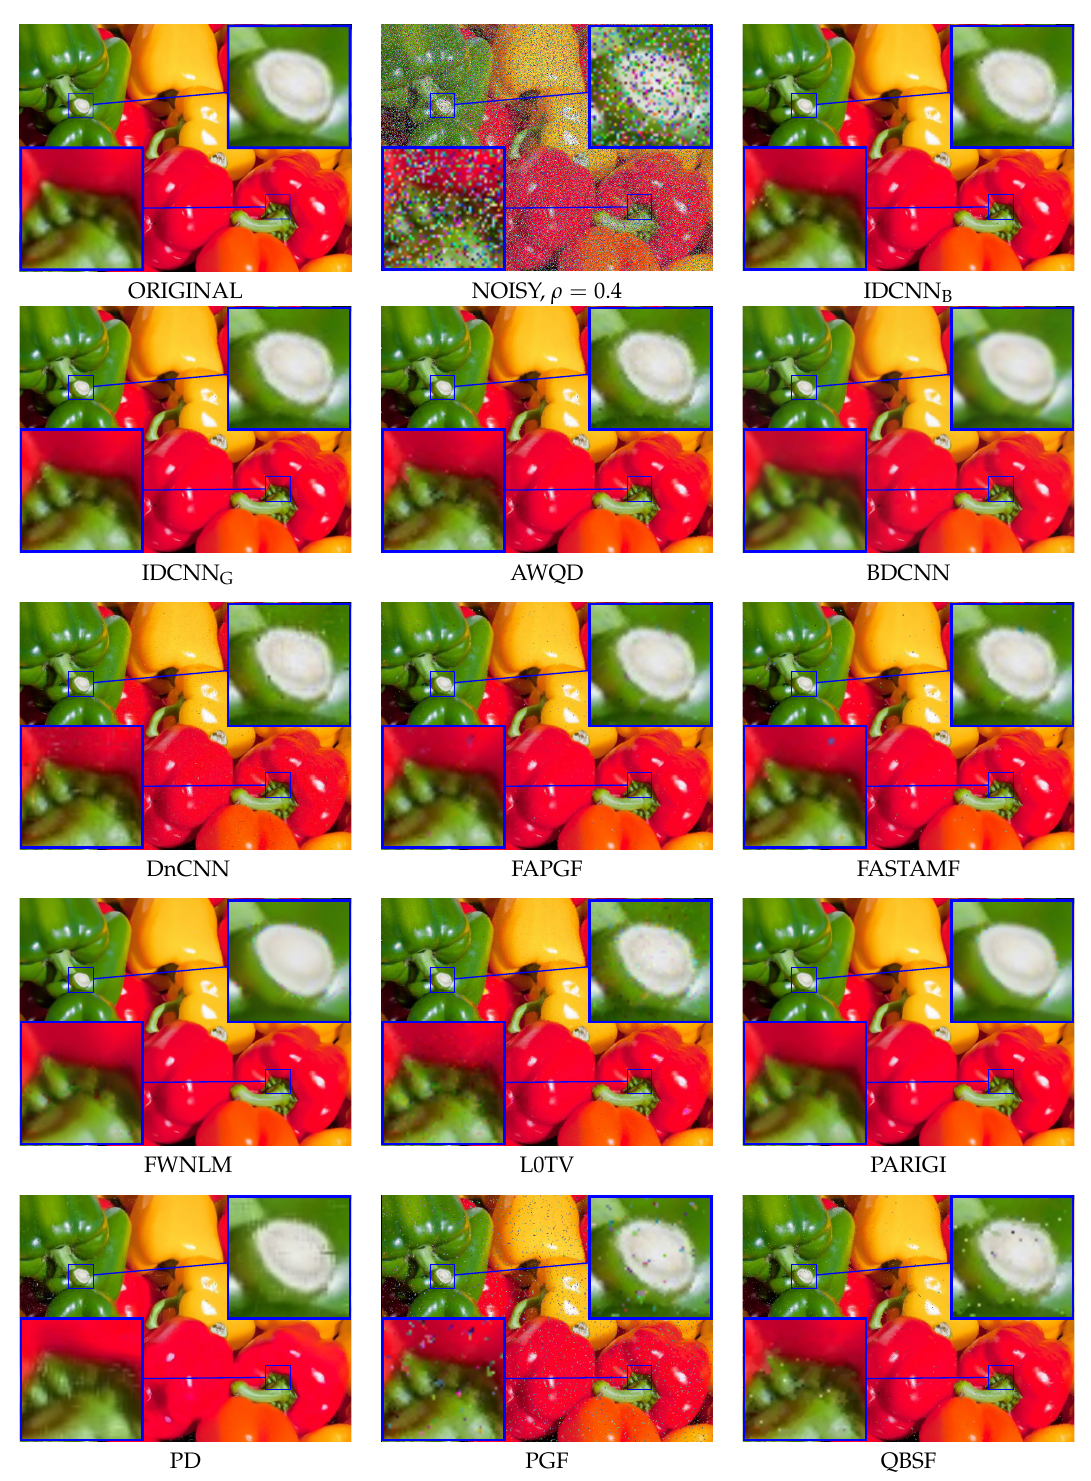
Figure 13. Visual comparison of the filtering efficiency using a part of the PEPPERS image ( ρ =